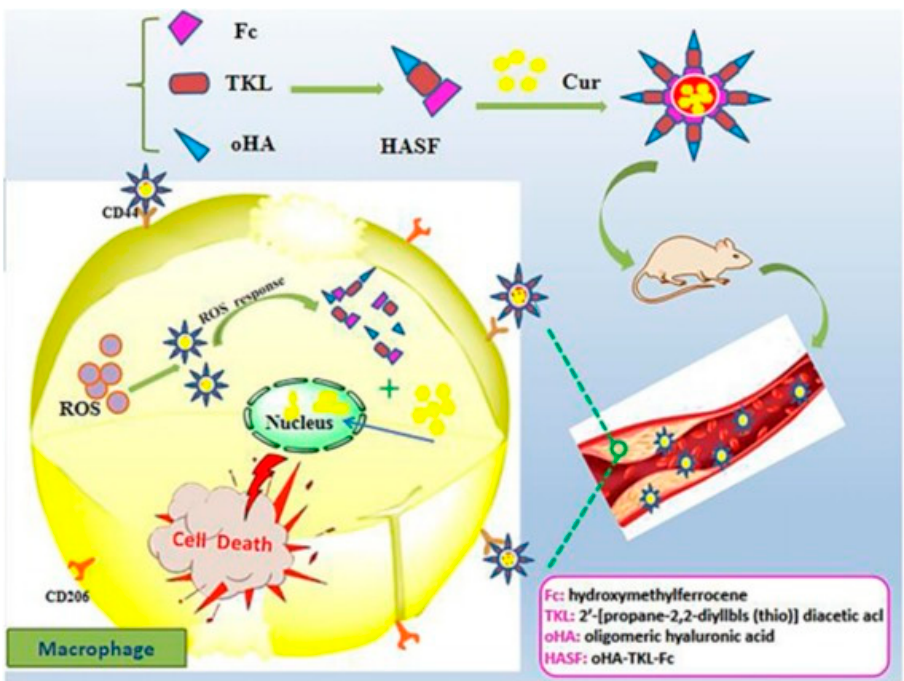
Figure 7. Cur release mechanism diagram of dual ROS-sensitive and CD44 receptor targeting nanoparticles. Reprinted with permission from Carbohydrate polymers Hou, X., et al., Novel dual ROS-sensitive and CD44 receptor targeting nanomicelles based on oligomeric hyaluronic acid for the efficient therapy of atherosclerosis, pages 115787. Copyright 2020, with permission from Elsevier [52].